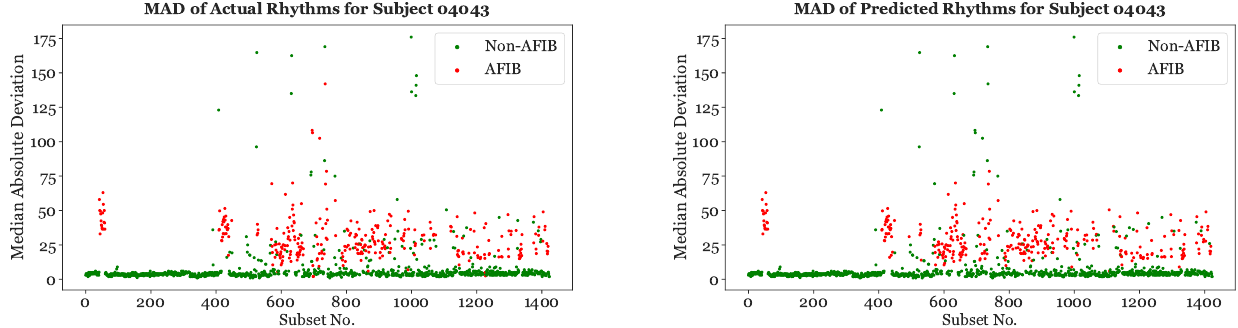
Figure 13. Actual ( left ) and XGBoost based ( right ) rhythms on 25-s subsets for Subject